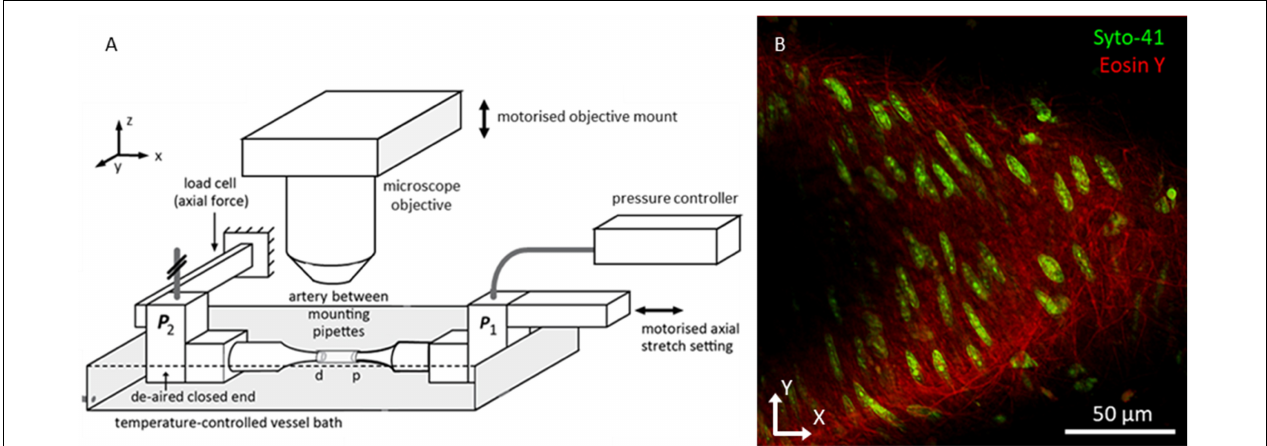
FIGURE 1 | Biomechanical testing setup allowing for imaging vessels under in vivo -like conditions. (A) Overview bi-axial biomechanical testing set-up. Samples were mounted with both ends fixed at glass pipettes. Pressure and axial force were measured at the closed-end distal pipet ( P 2 ). While measuring the axial force, the motorized proximal pipet was used to bring artery to its in vivo -like length. The setup was placed under the microscope with the objective situated above the artery. The motorized objective mount facilitated scanning through the sample along the z -axis to create a z-stack. (B) Representative two photon fluorescence microscopy image of mouse carotid artery wall. Green channel shows cell nuclei; red channel shows the elastin fiber network. Because vessels did not always lay flat in the imaging plane, the vessel wall tended to take on a parabolic shape in the imaging plane, as visible in this example.